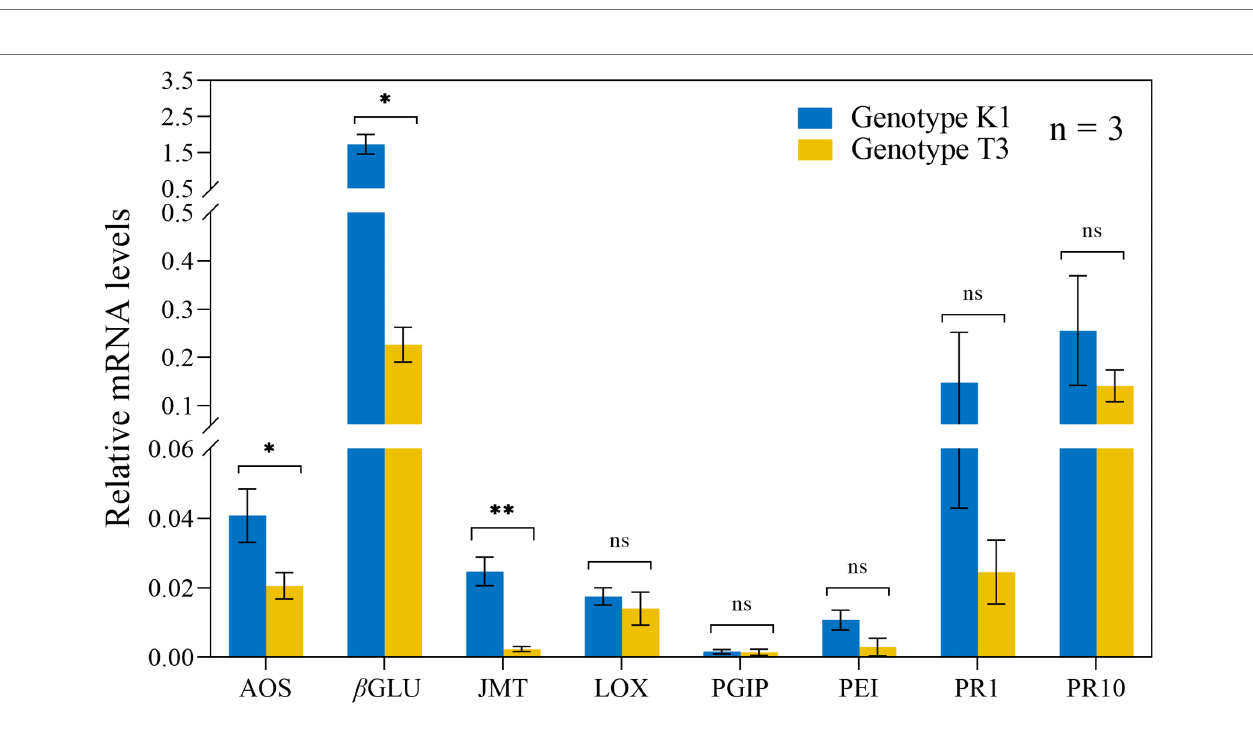
FIGURE 4 | Relative expression levels of eight defense-related genes in leaves of Kreuzkogel 1 (K1) and Tenno 3 (T3), prior to B. cinerea inoculation, were measured via qRT-PCR. All values were normalized to the expression level of the H4 and UBC9 housekeeping genes. Significant differences between two genotypes, based on the generalized linear models (glm), are represented by ns p > 0.05, * p < 0.05, ** p < 0.01. AOS, ALLENE OXIDE SYNTHASE; β GLU, β -1,3- GLUCANASE; JMT, JASMONIC ACID CARBOXYL METHYLTRANSFERASE; LOX, LIPOXYGENASE; PGIP, POLYGALACTURONASE INHIBITOR PROTEIN; PEI, PECTINESTERASE INHIBITOR; PR1, PATHOGENESIS-RELATED PROTEIN FAMILY 1; PR10, PATHOGENESIS-RELATED PROTEIN FAMILY